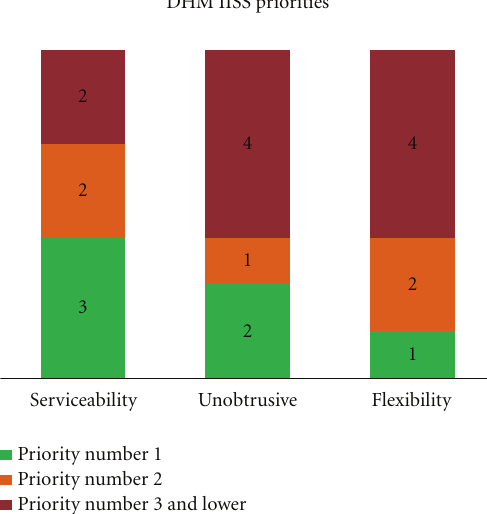
Figure 1: Subject matter expert